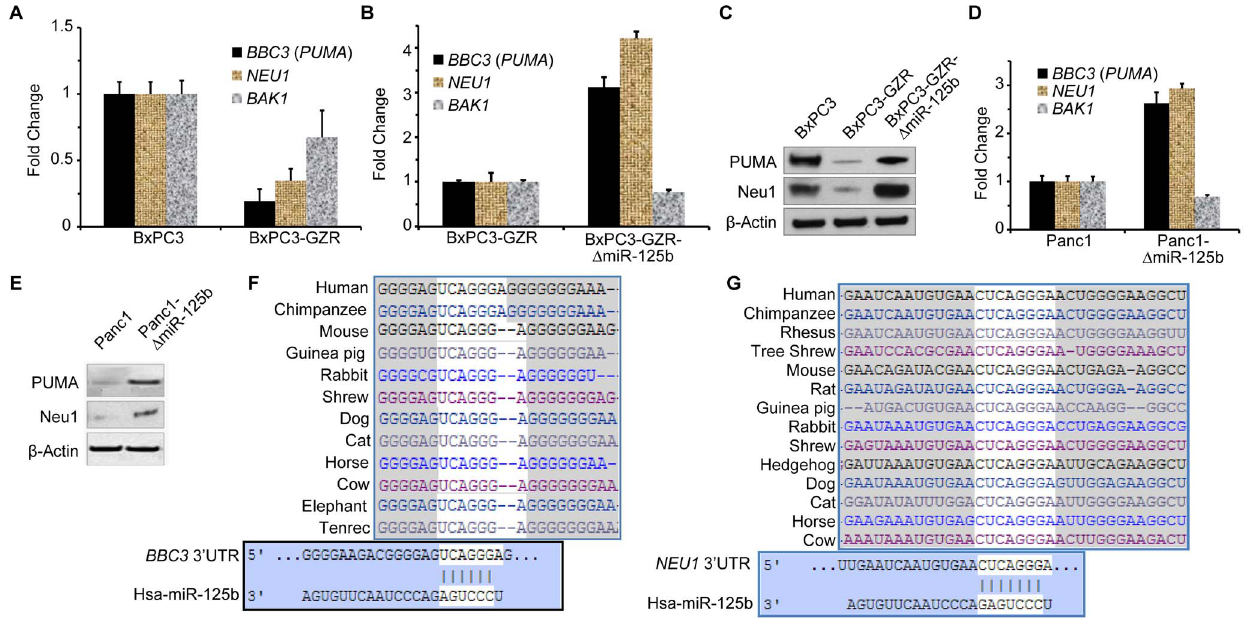
Figure 6. Validation of miR-125b target genes by qPCR and Western blot assays. A. PUMA ( BBC3 ) and Neu1 are most prominent mRNA targets of miR-125b. The TaqMan qPCR analyses were performed to validate clinical data. The qPCR results indicating the expression level of different mRNA ( BBC3, Neu1 and BAK1 ) which are direct target of miR-125b compared between BxPC3 parental cells and resistant GZR cells. B. Comparison of mRNA expression level of BBC3, Neu1 and BAK1 in BxPC3-GZR cells and stable BxPC3-GZR cells expressing anti-miR-125b. C. Western blots analysis to monitor the expression level of PUMA and Neu1 in BxPC3, BxPC3-GZR, and miR-125b knockdown cells. D and E . Inhibiting miR-125b restores BBC3 and Neu-1 expression in Panc-1 cells, qPCR (D) and Western blot (E). F, G . Species conservation and matching of the seed sequence in 3 9 UTR of BBC3 and NEU1 mRNAs with miR-125b sequence were monitored by using Targetscan free web-based software.